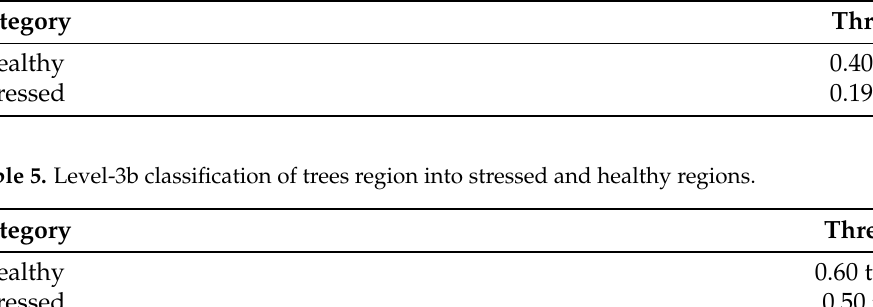
Table 4. Level-3a classification of shrub region into stressed and healthy regions.